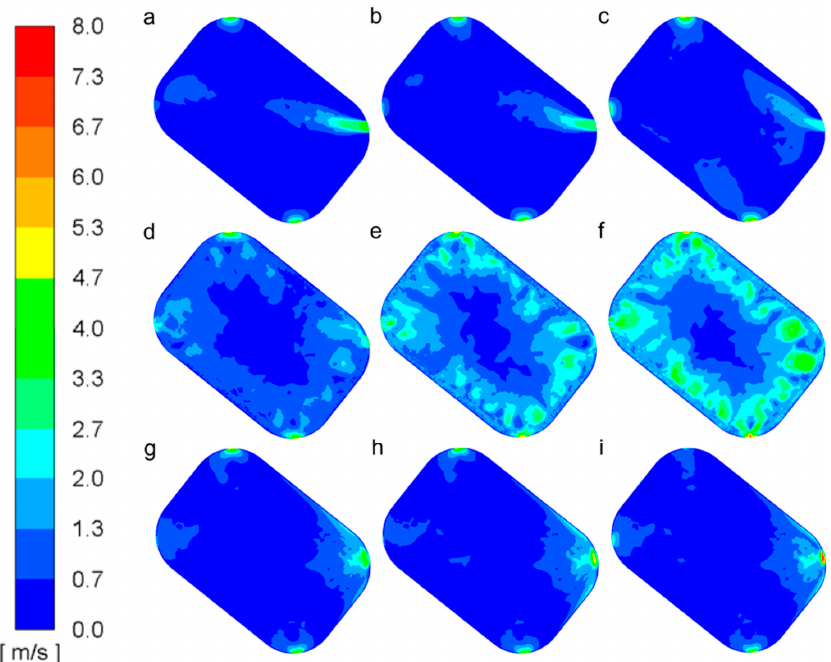
Figure 11. ( a – i ) Wind velocity magnitude distributions of the pitch (at a height of 2.1 m) for scenarios 1–9.